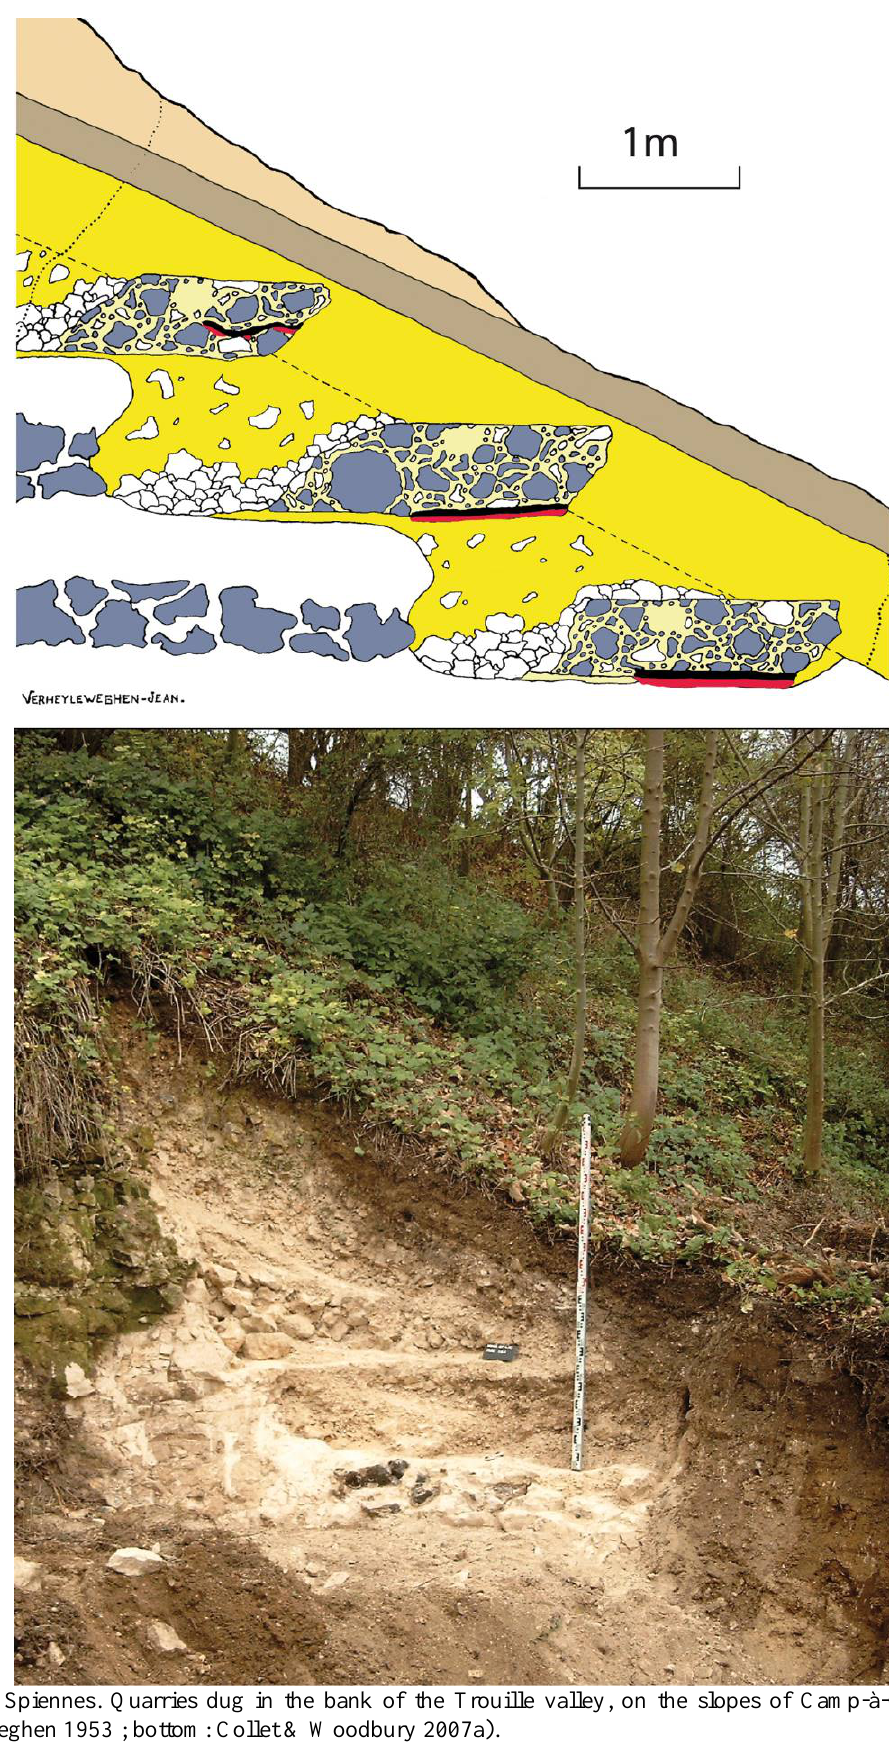
Figure 11. Spiennes. Quarries dug in the bank of the Trouille valley, on the slopes of Camp-à-Cayaux (top: Verheyleweghen 1953 ; bottom: Collet & Woodbury